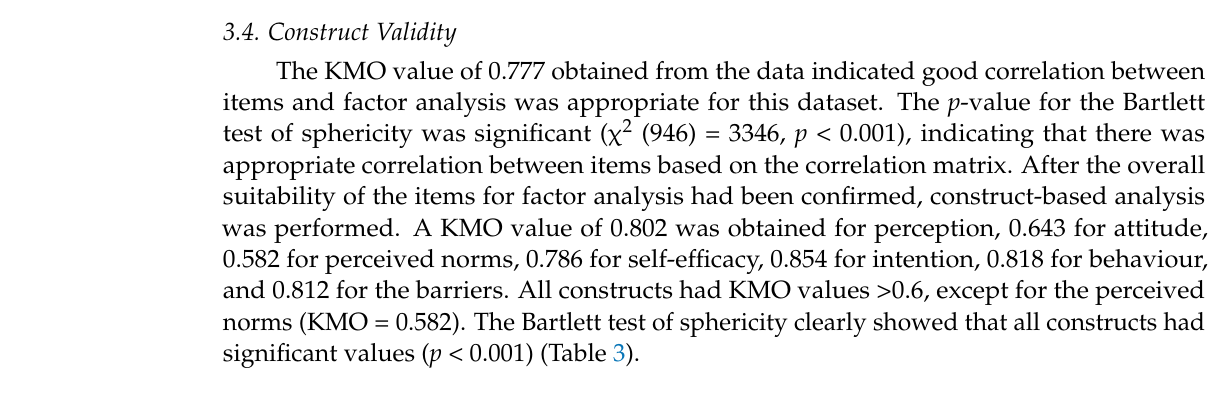
Table 3. Value of KMO and Bartlett’s test based on factor